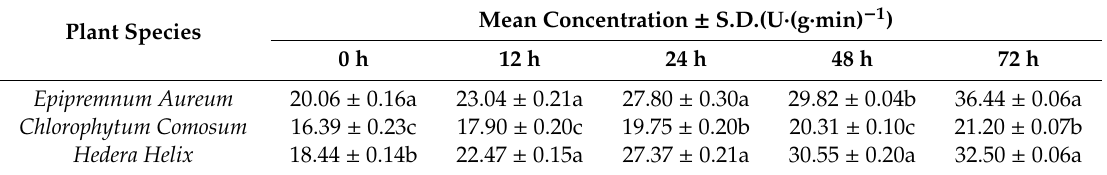
Table 2. Peroxidase (POD) activity of the three plants under di ff erent exposure times. Plant Species